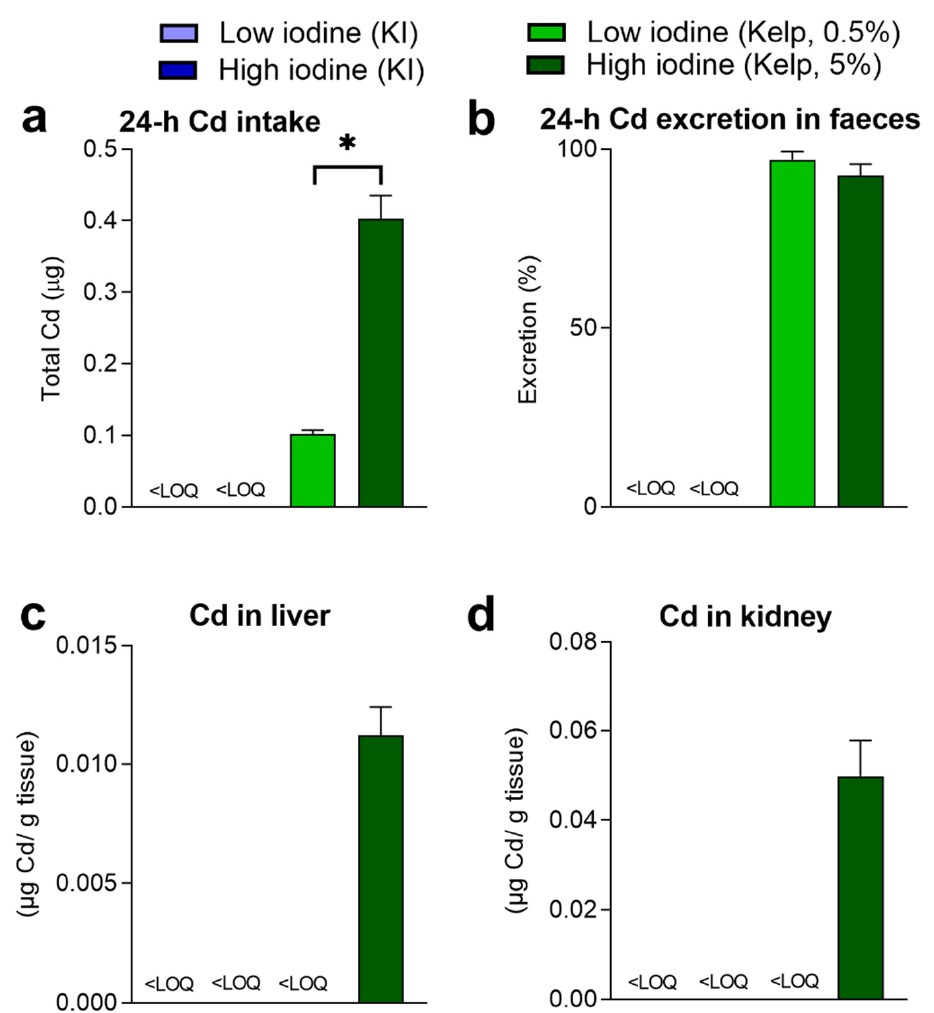
Figure 3. ( a ) 24 h cadmium (Cd) dietary exposure and ( b ) excretion in faeces in rats fed KI and sugar kelp in week 11. ( c ) Accumulated concentrations of Cd in liver and ( d ) kidney tissues after 11 weeks of feeding. Data are shown as the mean ± SEM ( n = 9–10). Measured values below the limit of quantification (LOQ) Cd = 0.0001 (mg/kg) are marked < LOQ. Significant differences between groups fed the two levels of kelp in the diet are marked with *. Data were analysed with a standard t -test; values in rats fed KI were below LOQ.